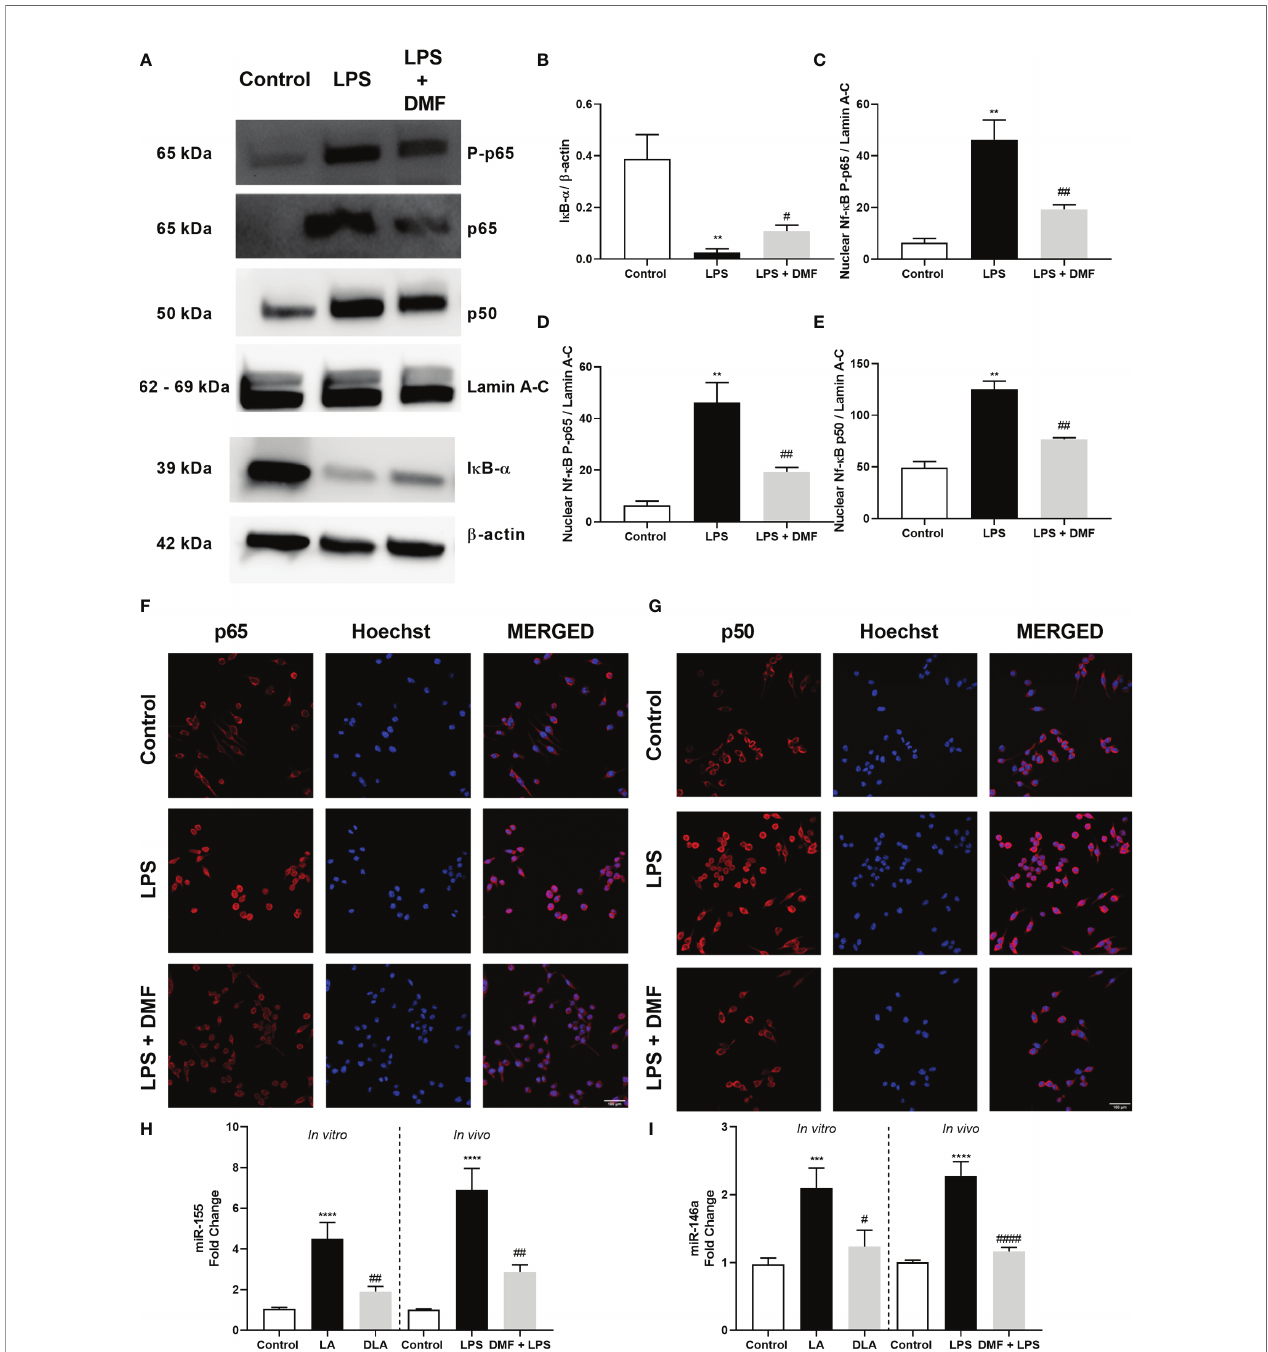
FIGURE 5 | DMF prevented the translocation of NF- k B into the nucleus and altered miR-155 and miR-146a expression. N9 microglia were pretreated with DMF (10 µM) for 1hour, primed with UP-LPS (1000 ng/ml) for 1hour. DMF modulated NF- k B activity by inhibiting the translocation of p-p65, p65, and p50 subunits of NF- k B protein complex into the nucleus (A). The expression level of I k B- a (B), translocation of p-p65 (C) , p65 (D), and p50 (E) subunits of NF- k B were demonstrated with Western blot. Translocation of p65 (F) and p50 (G) subunits of NF- k B was demonstrated by IF staining (Red staining – NF- k B subunits, Blue staining – Hoechst). DMF also downregulated the expression of miR-155 and miR-146a. Expression levels of (H) miR-155 and (I) miR-146 in LPS+ATP treated N9 microglia and LPS challenged mice were measured with RT-qPCR. Data are presented as mean ± S.E.M, n = 5. **p < 0.01, ***p < 0.001, ****p < 0.0001 compared to control and # p < 0.05, ## p < 0.01, ### p<0,001 compared to LPS-primed